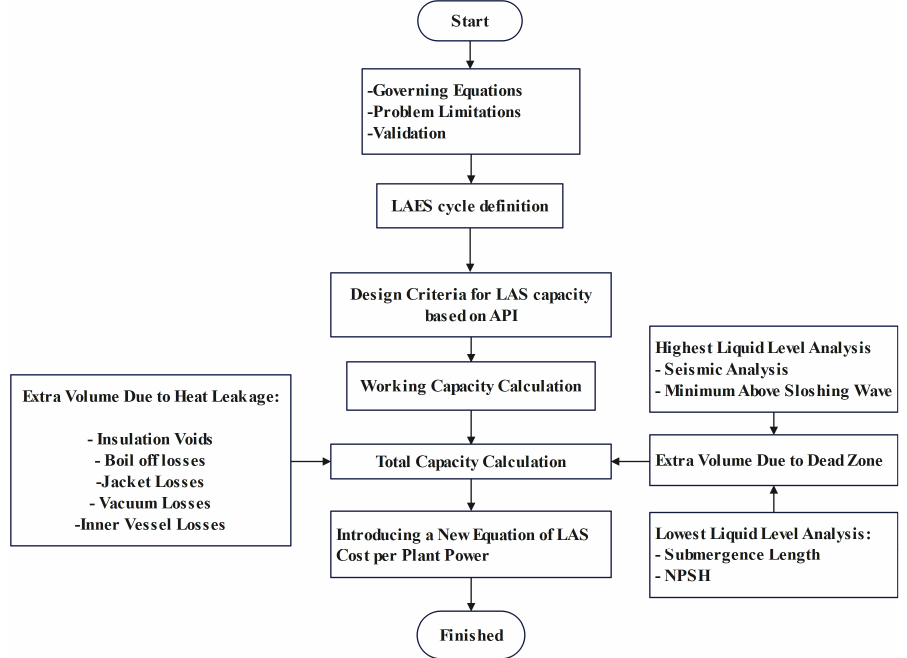
Figure 6. Solution fl owchart for estimating the LAS capacity and